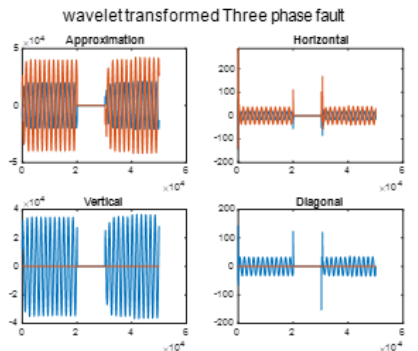
Figure 16. Waveforms of IMF 2 and instantaneous amplitude of phase B